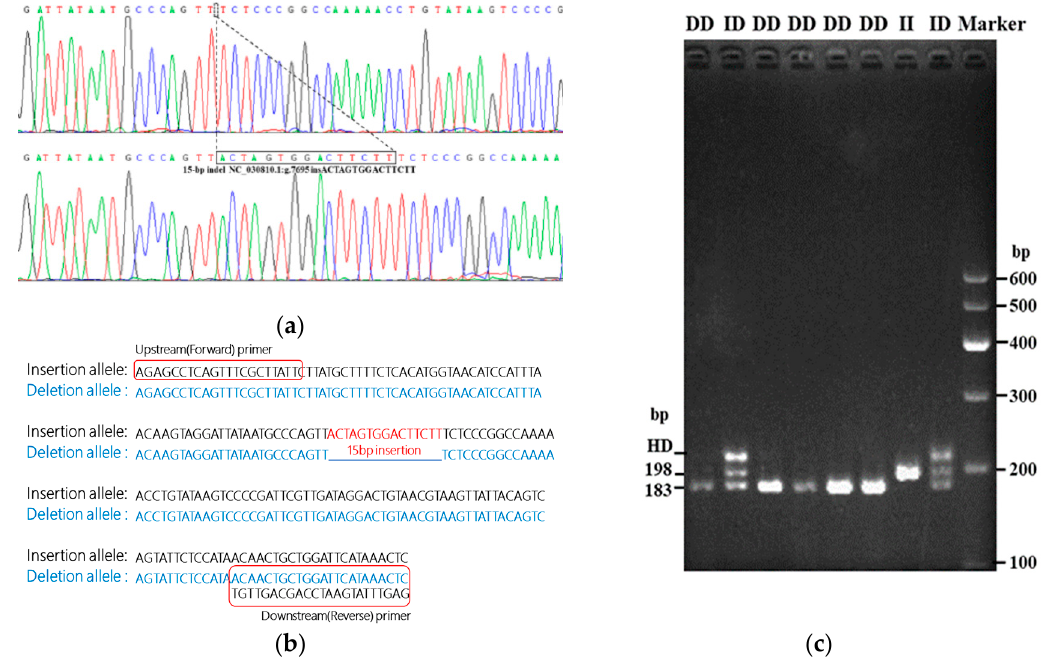
Figure 2. ( a ) Sequence diagram of the rs665862918 mutations of the goat HIAT1 gene. ( b ) Analysis of the 15 bp indel sequence of the goat HIAT1 gene in reference to NC_030810.1. ( c ) Electrophoresis assay of the rs665862918 locus of the HIAT1 gene of goat (3% agarose gel electrophoresis). HD,